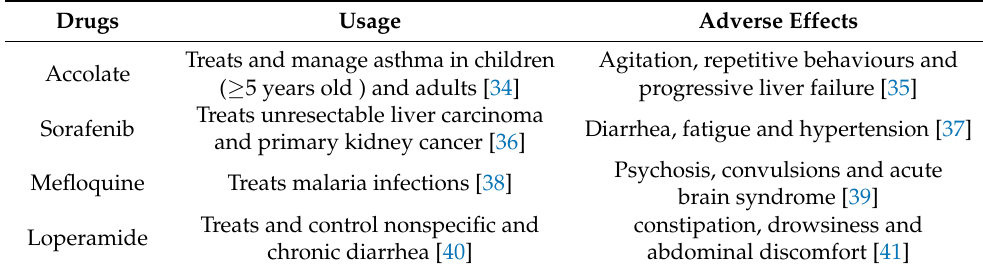
Table 4. Usage and adverse effects of identified Mtb FadD32 potential inhibitors.